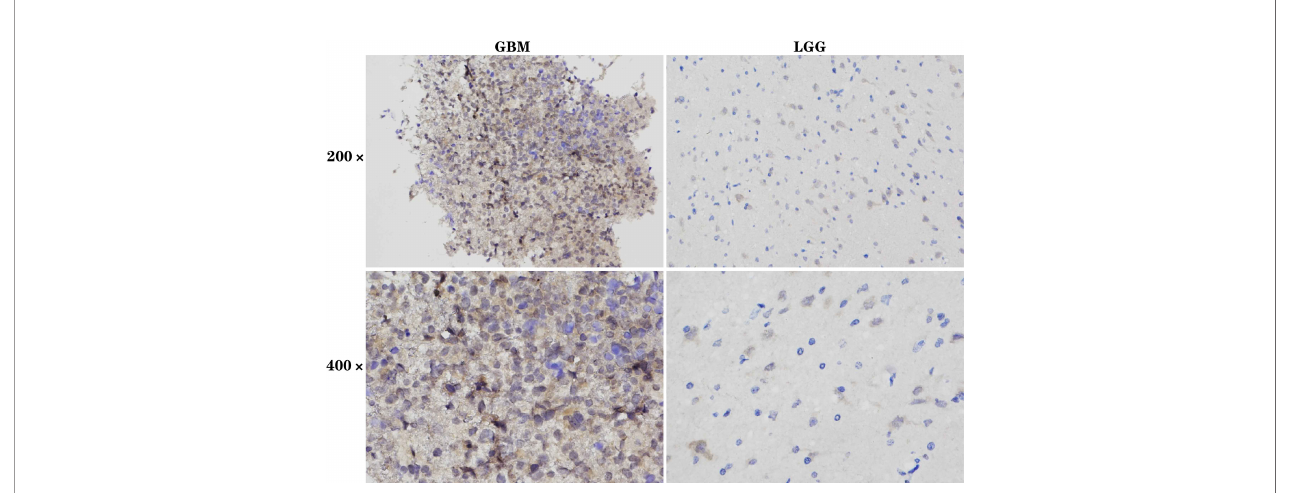
FIGURE 12 | The experimental validation of SOCS3 by IHC. Expression of SOCS3 in GBM and LGG tissues is shown at 200× and 400× magni fi cation, respectively. It is found that SOCS3 is highly expressed in GBM and low expressed in LGG.